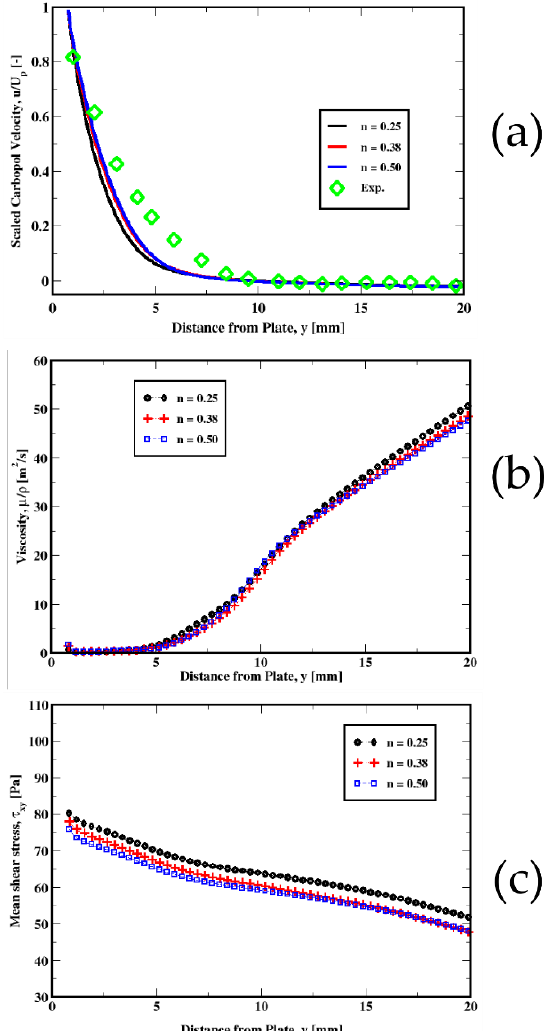
Figure 12. Influence of the power-law exponent on the distribution of the velocity of the fluid ( a ) (top plot) for the plate immersion velocity of 1 mm/s. The middle ( b ) and the bottom( c ) plots represent the variation in the kinematic viscosity and the mean shear stress, respectively.